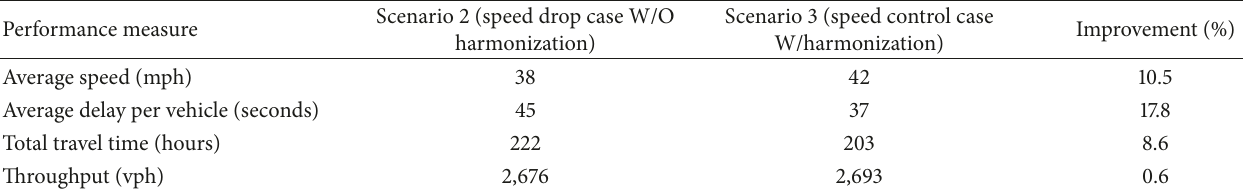
Table 2: Network performance for Scenarios 2 and 3 under 100% C/AV market penetration.